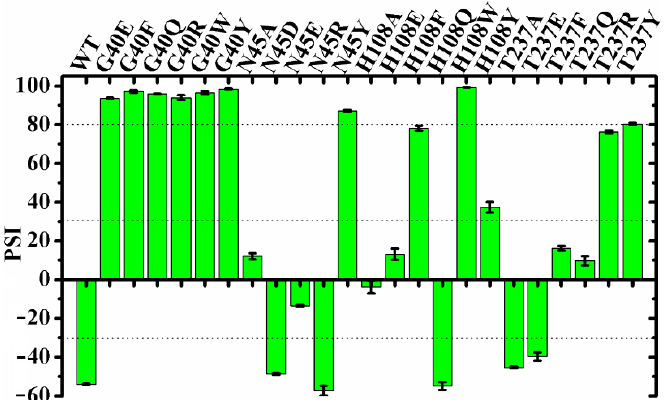
Figure 3. The PSI values of MAS1 and its